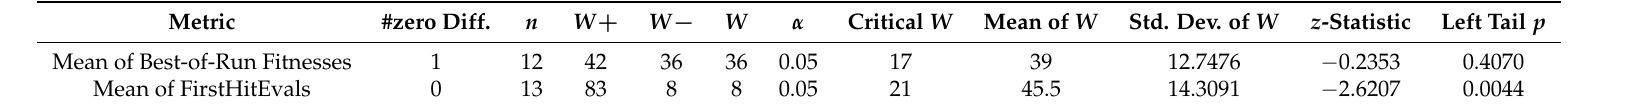
Table 13. Wilcoxon signed rank tests: Algorithm of [24] vs. Sjaya on the fuel cell